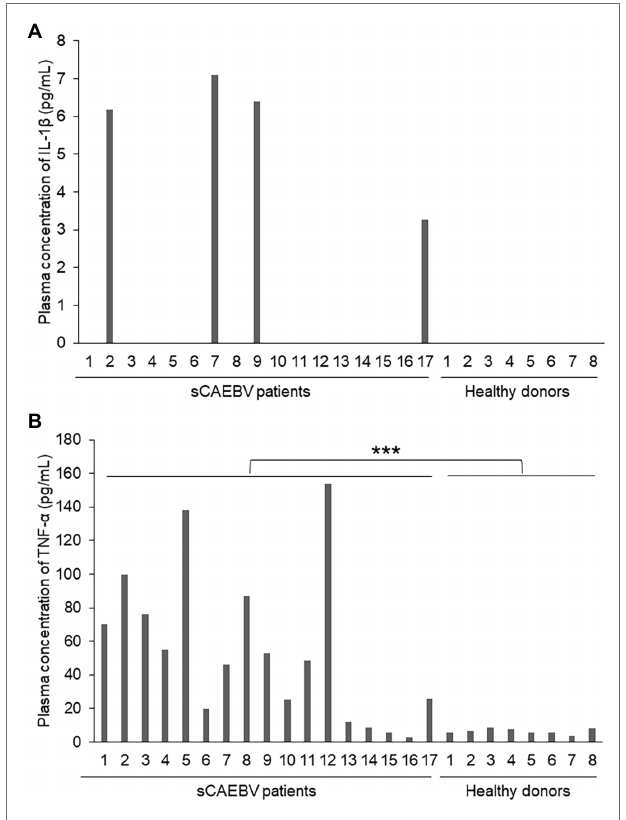
FIGURE 1 | The concentrations of interleukin-1 β (IL-1 β ) and tumor necrosis factor- α (TNF- α ) in the plasma of Systemic chronic active Epstein–Barr virus infection (sCAEBV) patients. (A) IL-1 β and (B) TNF- α concentrations in sCAEBV patients plasma measured by high-sensitivity cytokine beads assay. (A) IL-1 β was detected only in patient 2, 7, 9, and 17. (B) The TNF- α concentration of patient’s plasma was significantly higher than that of healthy donors (*** p < 0.001).